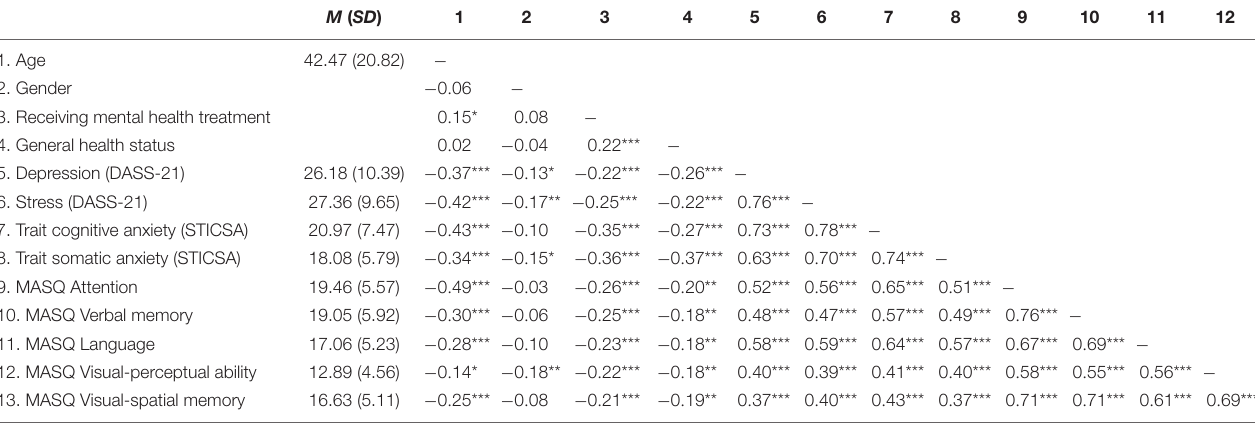
TABLE 2 | Mean values (with SD s) and Pearson correlations amongst predictor, control, and outcome variables. M ( SD )